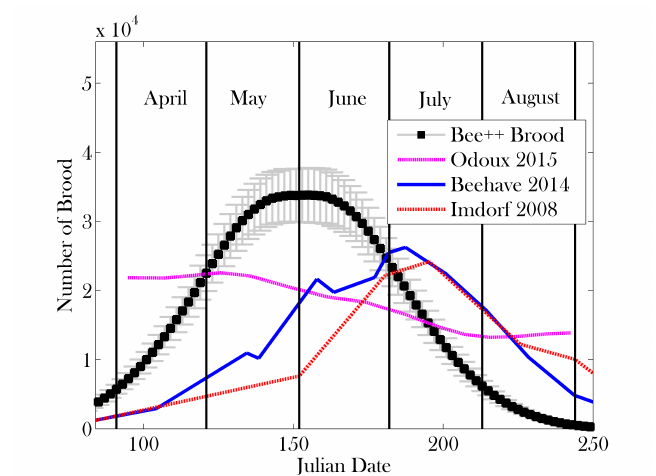
Figure 8. A comparison of brood size obtained using 10 simulations of Bee++ with simulation [52], observed data (Imdorf) [73], and fitted data (Odoux) [70]. Again we have simulated data for a well established colony, and note that the temporal distribution of brood size is influenced largely by the function used to model the laying rate of the queen. As in Figure 7, we see consistent qualitative agreement in all cases except in comparison to [70], which represents fitted data averaged over many colonies. Given the 21 days development time of the brood, the peak in the brood appears roughly 21 days before the peak in adult bee numbers. The simulation in Bee++ assumed constant availability of food throughout the spring and summer. Since brood survival depends in part on the available food, we see a much smoother